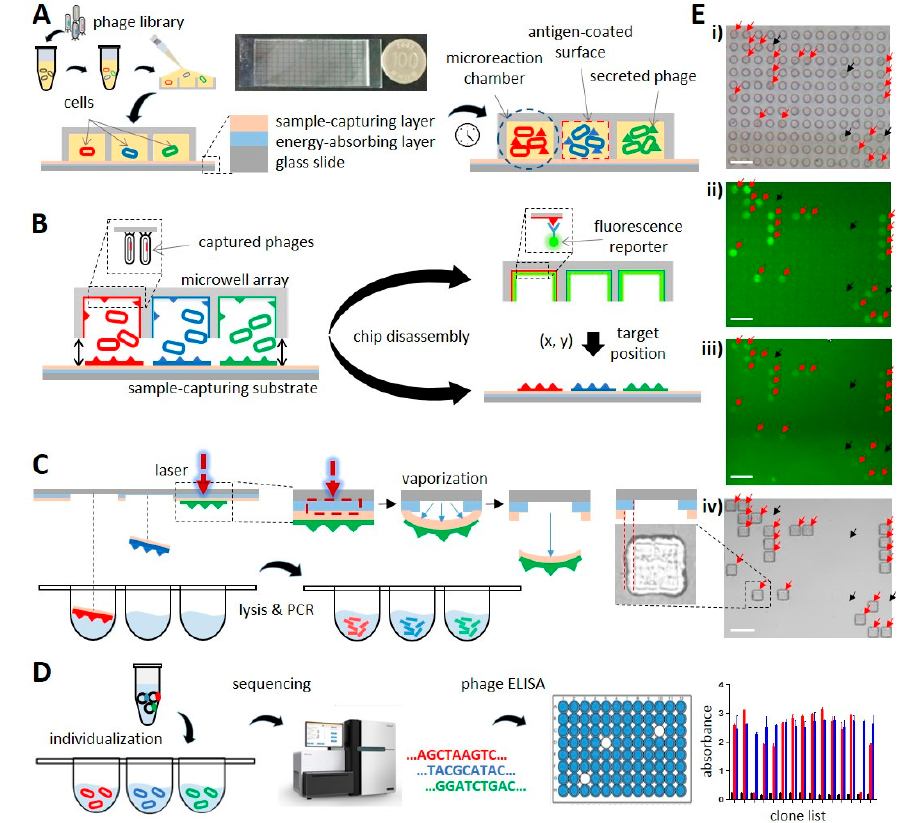
Figure 1. A schematic view of our platform. ( A ) Individualized growth of phage-infected cells. A microwell array and sample-capturing substrate were assembled to separate bacterial cells within microreaction chambers. ( B ) Disassembly of the microwell array chip. The microwell array was labeled withafluorescencereporterforthephagefluorescencemicrowellimmunoassay. ( C )Laser-drivensample retrieval. Phages captured on a sample-capturing layer were retrieved, and their phagemid DNAs were amplified. The inset shows an image of the sample-capturing substrate after pulse-laser irradiation. ( D ) Sequencing analysis of retrieved phage clones. The selected samples were subjected to high-throughput clonal retrieval and phage ELISA. ( E ) Representative microscopy images corresponding to each step of the workflow: brightfield image of the assembled microwell array chip ( i ), fluorescence images of the microwell array ( ii ) and sample-capturing substrate ( iii ) after fluorescence reporter conjugation, and brightfield image of the sample-capturing substrate ( iv ) after sample retrieval. Cell-occupied microwells with / without fluorescence signals and the corresponding spots on the sample-capturing substrate are indicated by red / black arrows, respectively. All scale bars are 200 µ